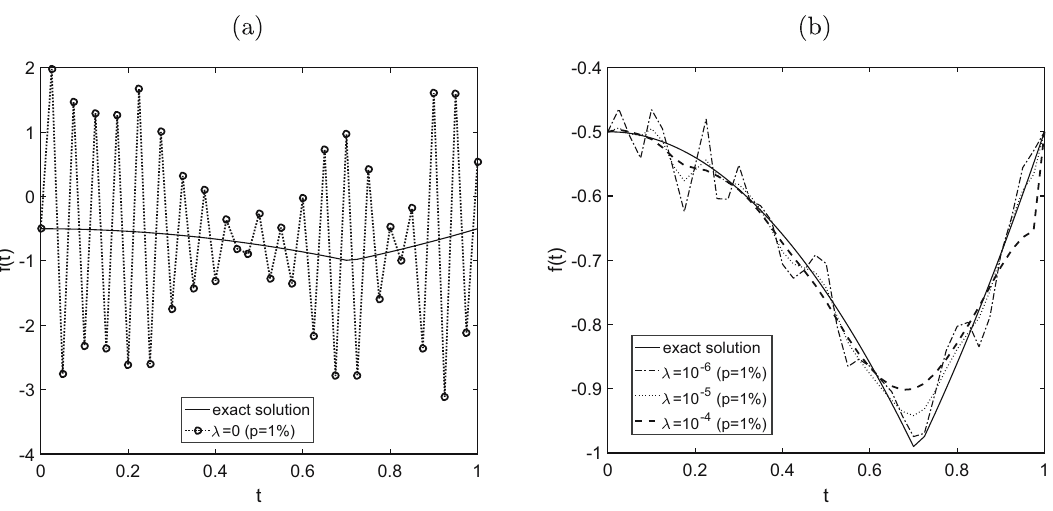
Figure 9: The exact ( 89 ) and approximate ( ) f t , for = p 0.1% with λ : ( a ) 0 and ( b ) 10 , 10 , 10 −6 −5 −4 , for Example 2.